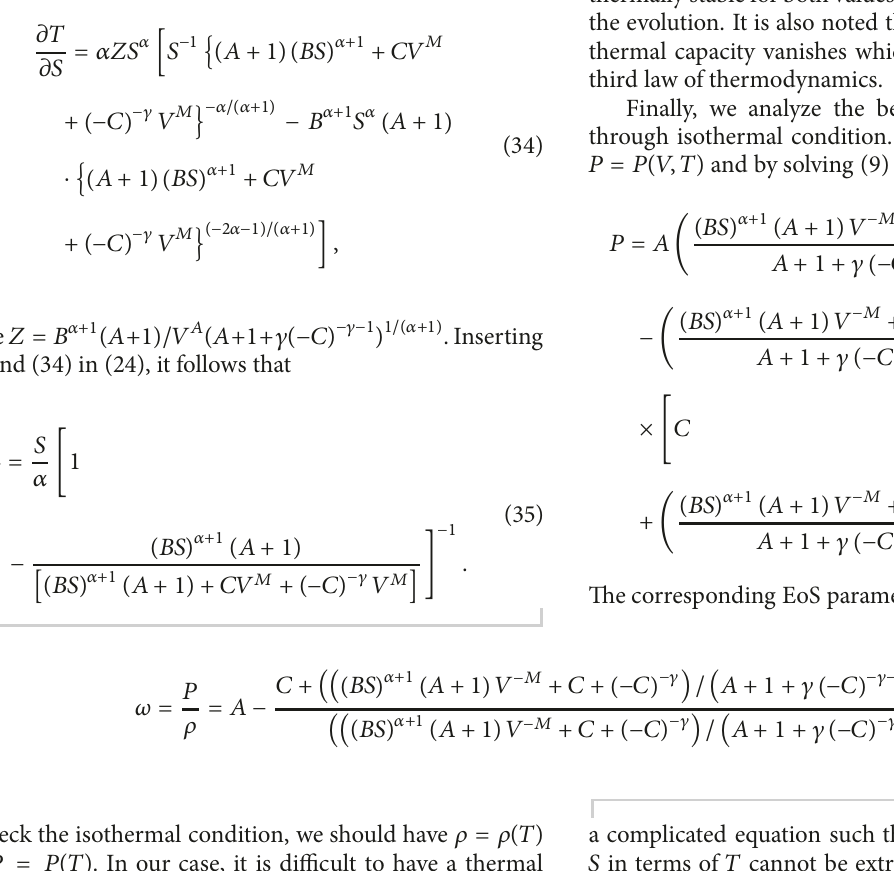
For a positive definite entropy, we assume 0 < 𝑇 < 𝜏 and 0 < 𝑉 < ] . It is worth mentioning here that when 𝑇 = 0 , the entropy vanishes which indicates that the considered fluid obeys third law of thermodynamics (if the temperature of a physical system approaches zero then entropy becomes